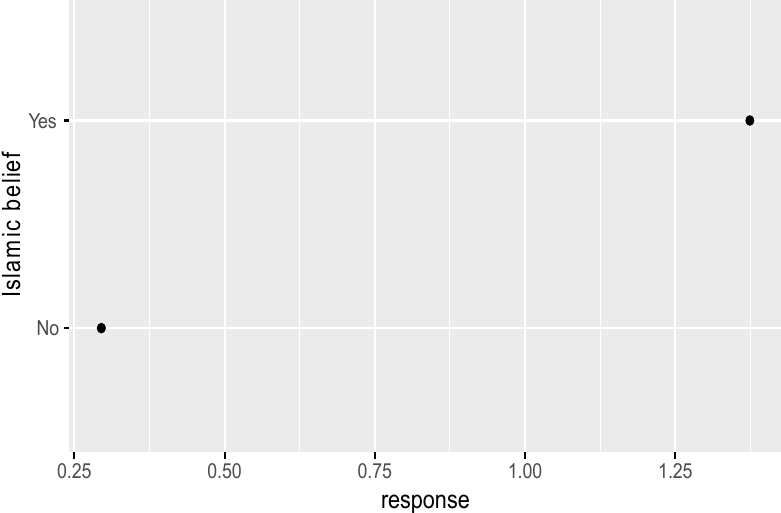
Figure 7. Zero-inflated regression coefficient of Islamic belief.